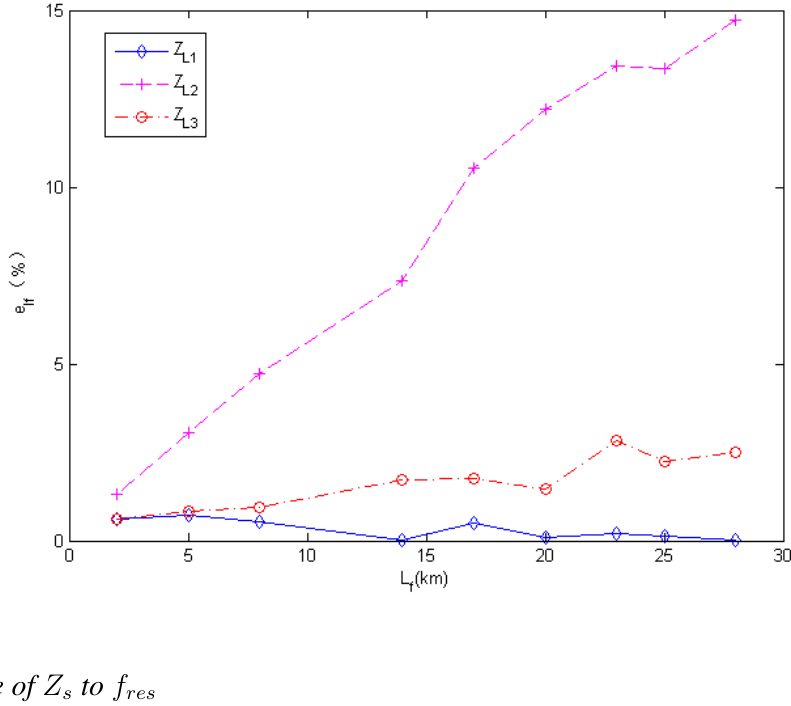
on the algorithm. l